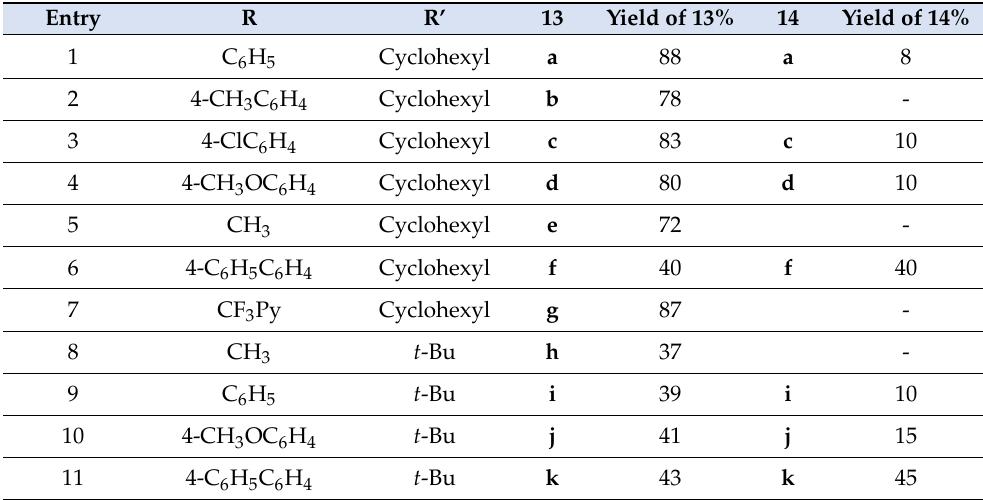
Table 1. Derivatives and yields of products 13a – k , 14a , c , d , f , i – k